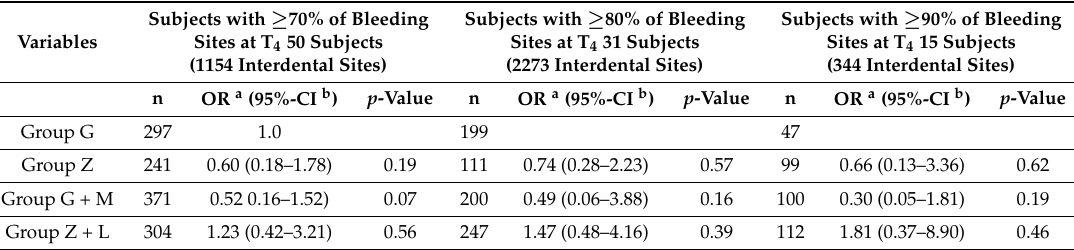
Table 4. Distribution of variables at interdental site level and multivariate associations in the different high-risk groups between the studied variables and interproximal bleeding at T 4 (4 weeks) (n = 2273 interdentals sites from 100